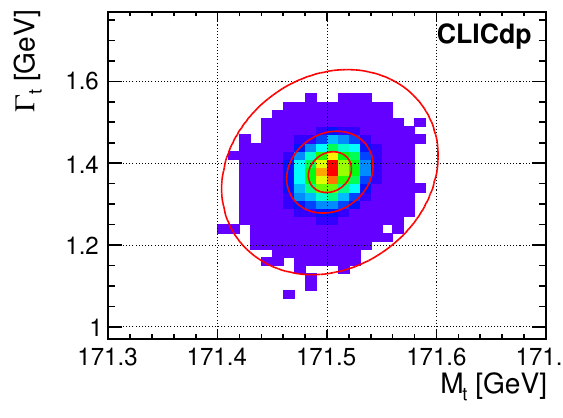
Figure 5 . Results of the two-parameter fits to the top threshold scan, for sets of pseudo-data generated for nominal parameter values, ˜ m sigma contours represent the 2-D Gaussian distribution fitted to the presented